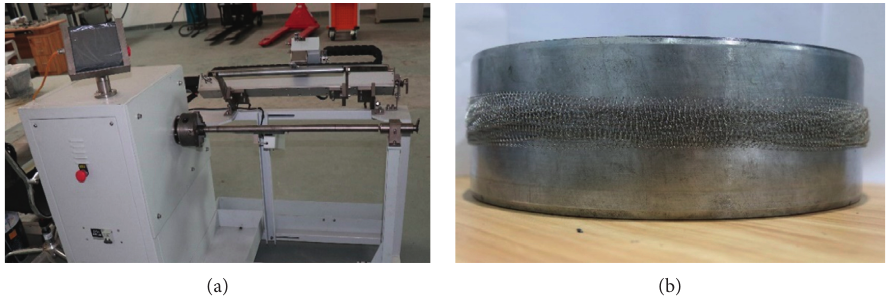
Figure 2: MRSM blank experimental preparation process. (a) NC blank winding equipment. (b) MRSM blank.